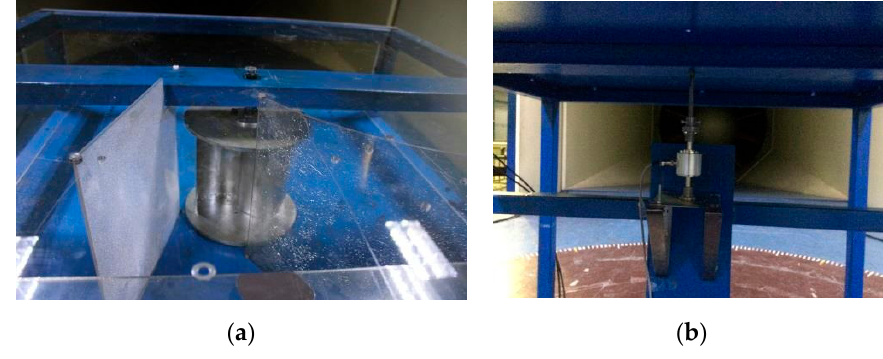
Figure 5. ( a ) wind rotor and the curtain; ( b ) torque meter.